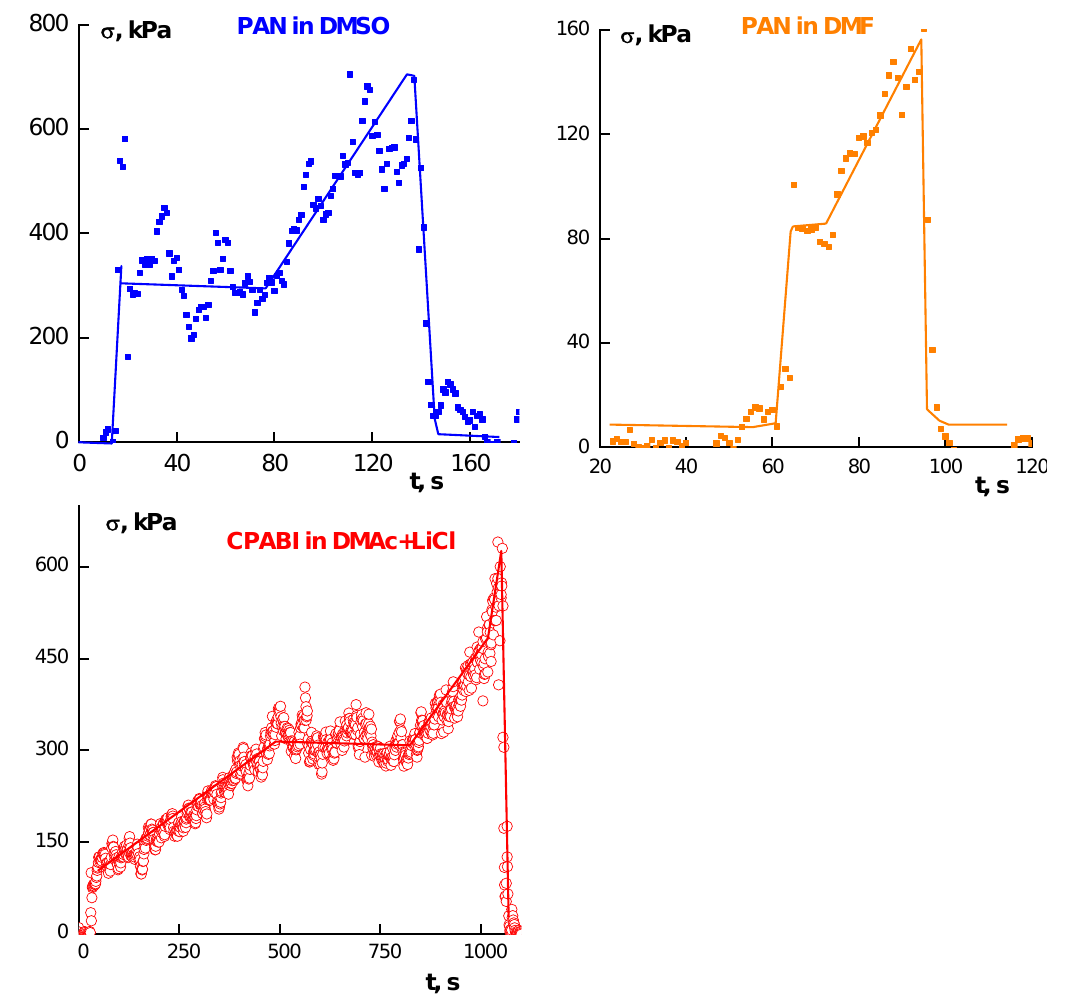
Figure 9. Stress development in extension of drops of PAN solutions in different solvents (upper rank) and of CPABI solution in DMAc + LiCl. and of CPABI solution in DMAc +